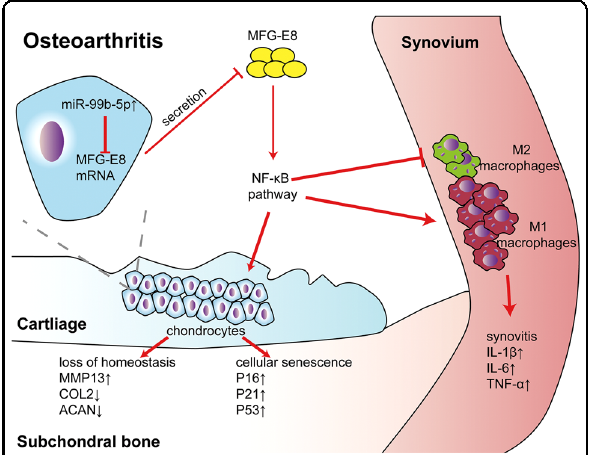
Fig. 7 Model of MFG-E8 secreted by chondrocytes in modulating chondrocyte homeostasis, senescence, and synovial macrophage polarization during OA. Increased miR-99b-5p inhibited MFG-E8 expression and secretion in OA, while decreased MFG-E8 disrupted chondrocyte homeostasis, promoted chondrocyte senescence, and unbalanced synovial macrophage polarization through NF- κ B signaling, thus accelerated OA